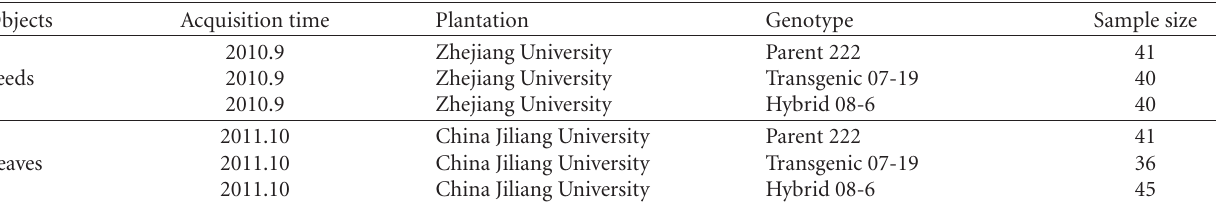
Table 1: Analyzed cotton